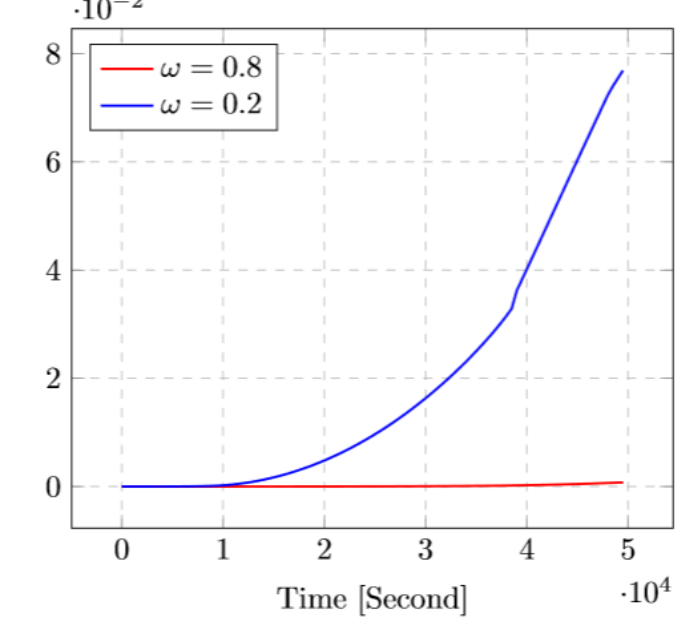
Figure A2. Diversity for an alternative environment, namely with ω = 0.8 and ω = 0.2 and 10